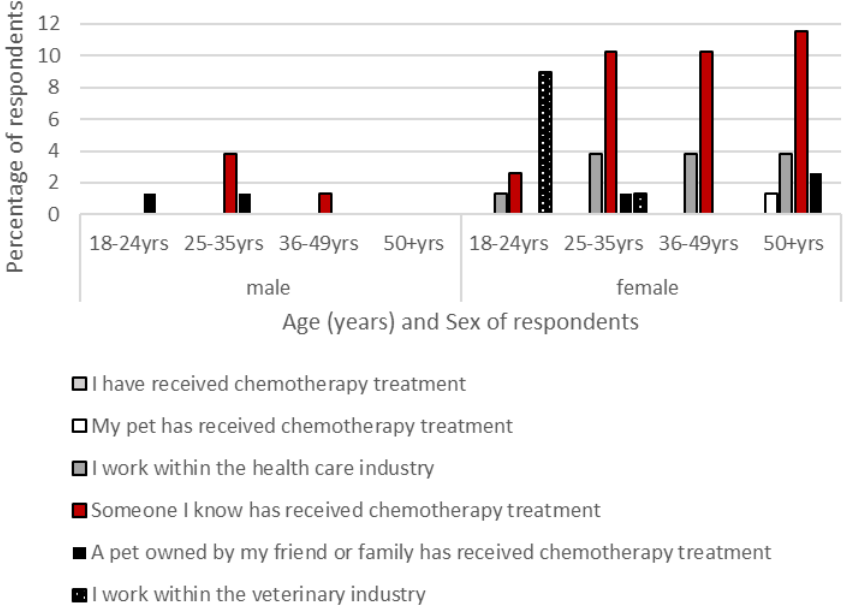
Figure 1. Participants’ previous experiences with chemotherapy treatment (CT).